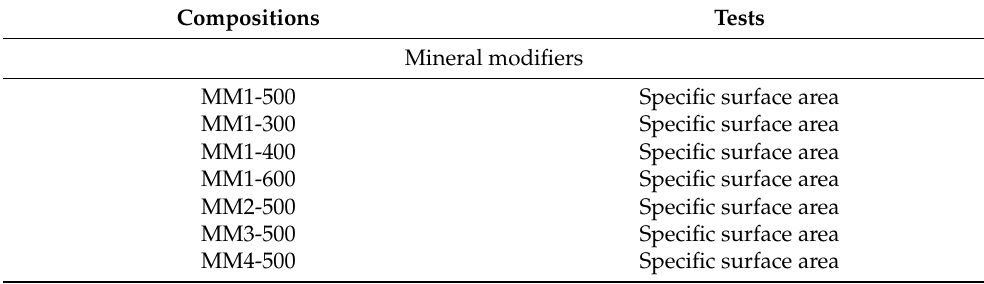
Table 6. Generalized list of all compositions and